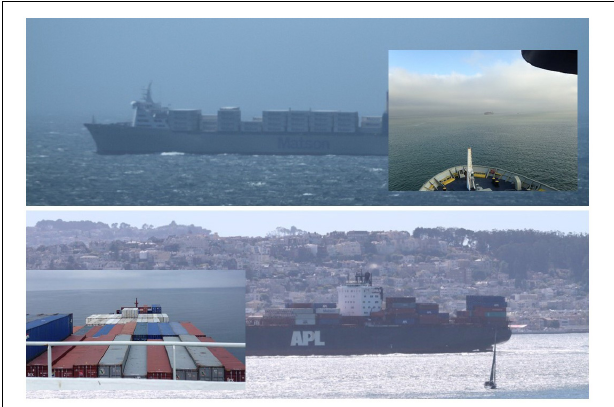
FIGURE 1 | Examples of ship configurations and views from ships that were part of this study including a ship with a forward bridge, voyages (3–5) (top) and a ship with a mid-aft bridge (bottom) during voyages 1 and